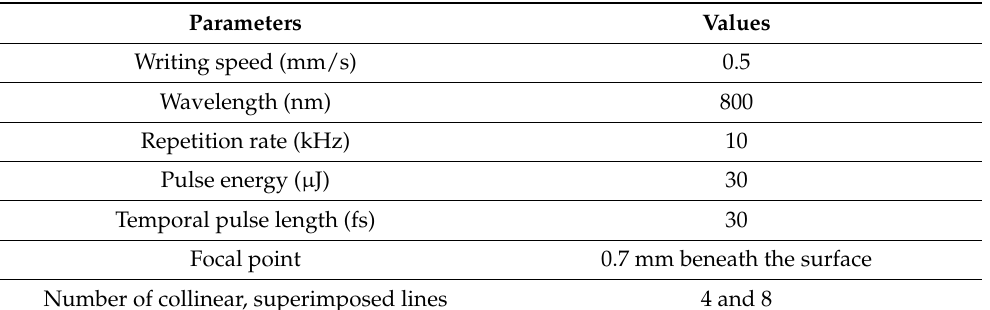
Table 1. Parameters used in the waveguide processing.